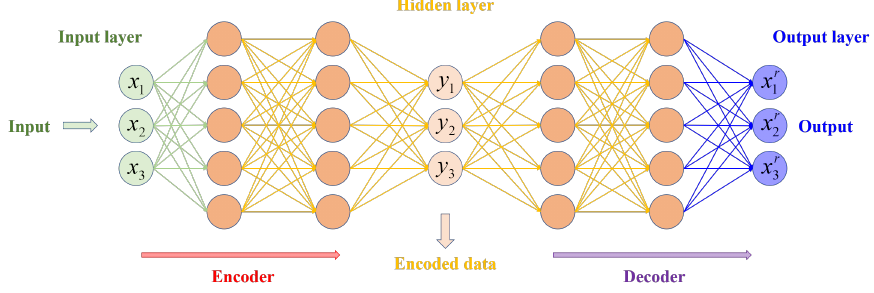
Figure 6. Example of AE architecture.